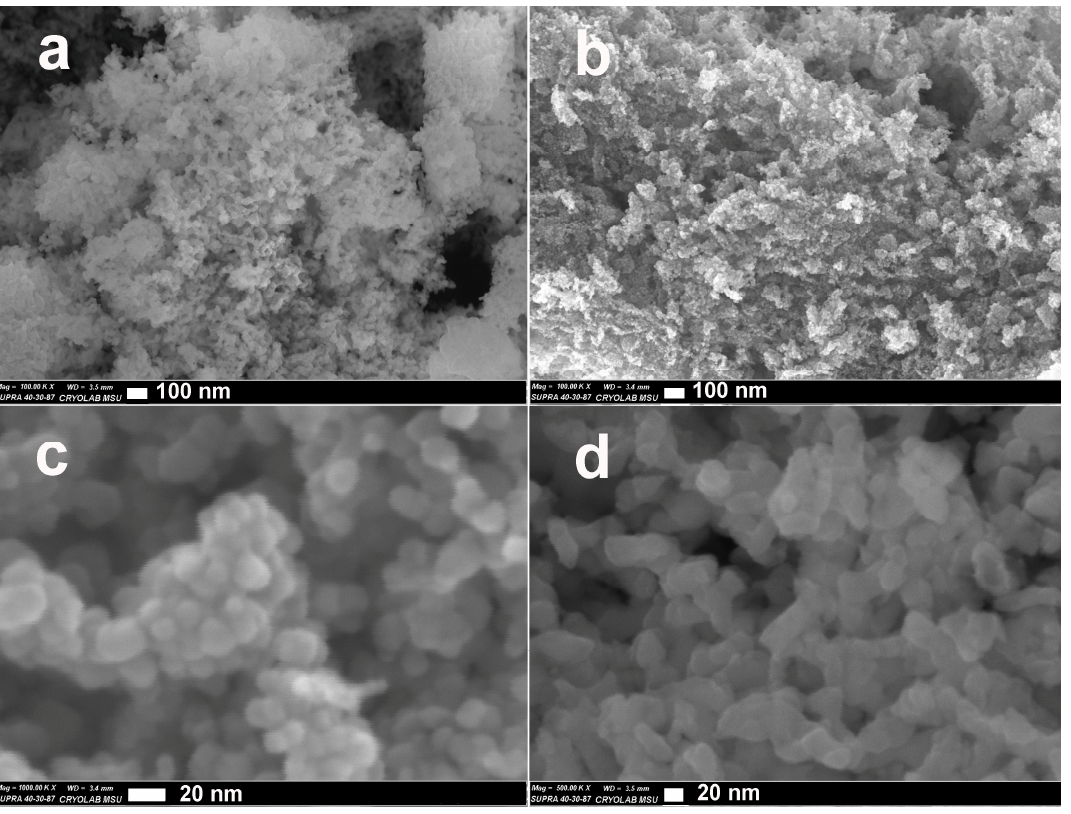
Figure 2. SEM images of LaFeO 3 ( a ), LaFeO 3 /Ag(5 wt.%) ( b ), LaFeO 3 /Pd(2 wt.%) ( c ) and LaFeO 3 /Pd(5 wt.%) ( d ).